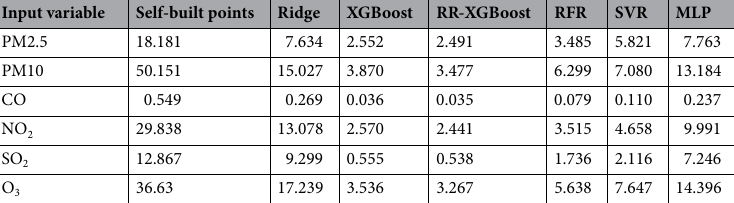
Table 6. MAE of six types of air pollutant concentrations between self-built points, model forecast values and national control point.